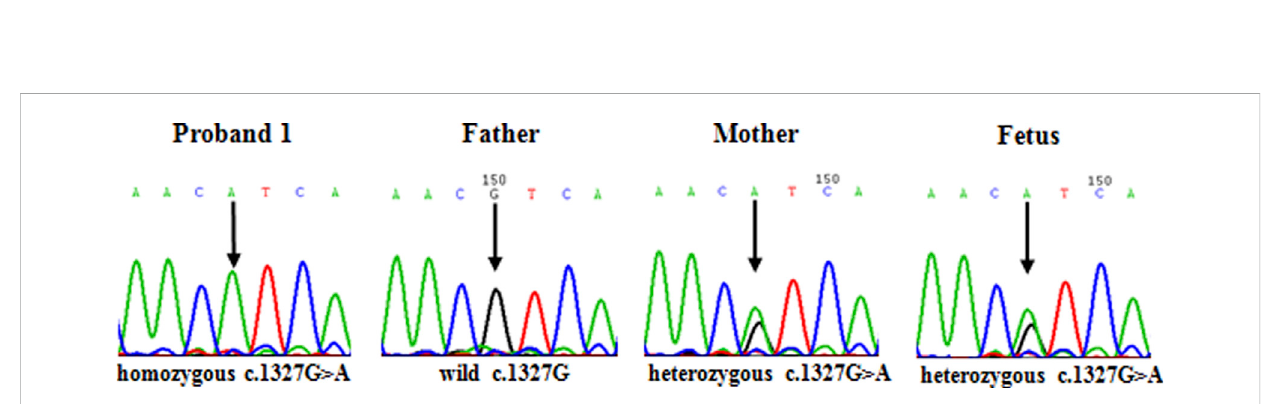
revealed that proband 1 had a microdeletion (chr15: 22330347- 26089649, approximately 3.8 Mb) between primers G and D7, which was in line with the distal breakpoint BP3 but signi fi cantly below the upstream proximal breakpoint BP2. Therefore, this variation represents a novel deletion found in PWS. Inprenatal diagnosis of family 1, linkage analysis con fi rmed that the fetal chromosome was normal in the PWS region, as shown in Figure 6.